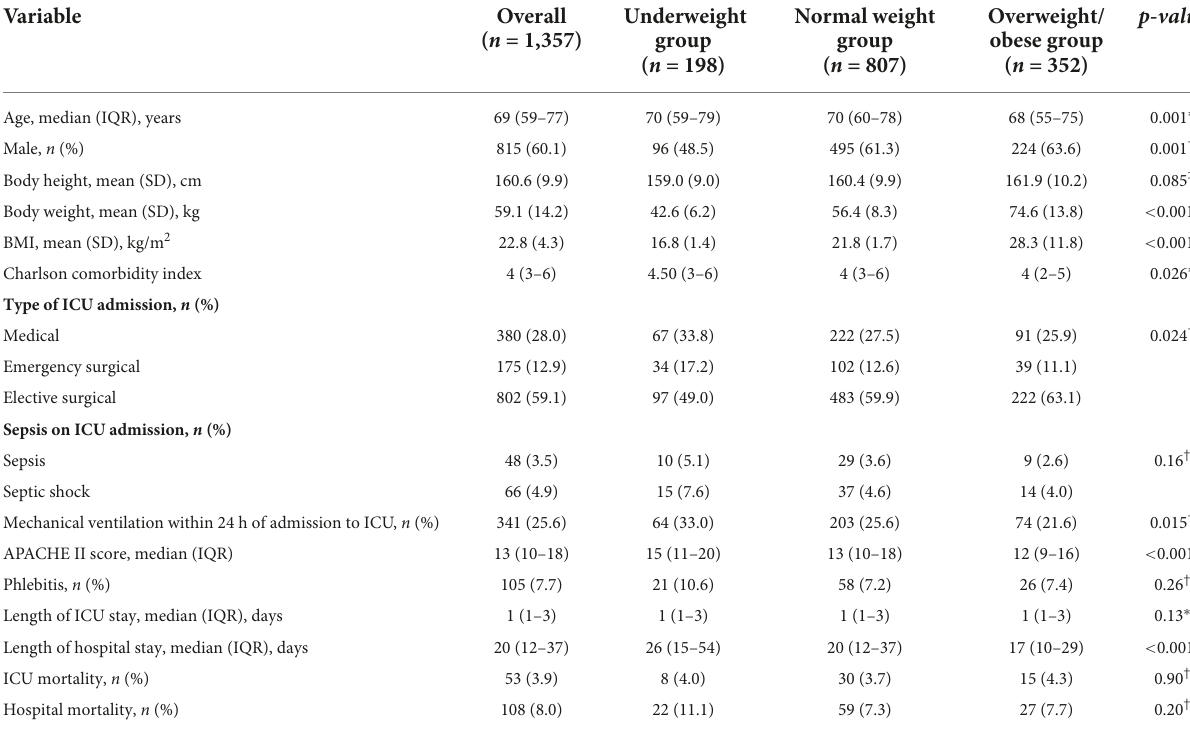
TABLE 1 Patient demographics, characteristics, and outcomes on intensive care unit admission stratified by body mass index.